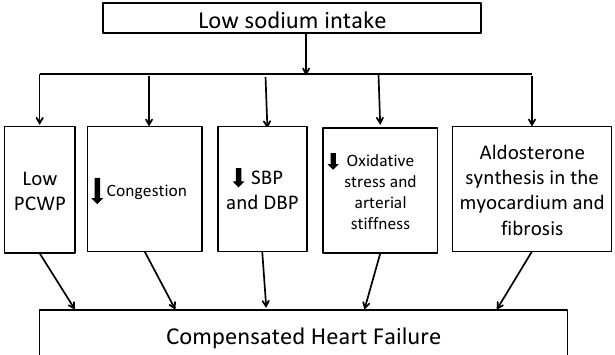
Figure 1. Potential mechanisms linking dietary sodium restriction to better heart failure outcomes DBP—diastolic blood pressure, PCWP—pulmonary capillary wedge pressure, SBP—systolic blood pressure. Abbreviations: DBP, diastolic blood pressure; SBP, systolic blood pressure; PCWP, pulmonary capillary wedge pressure.